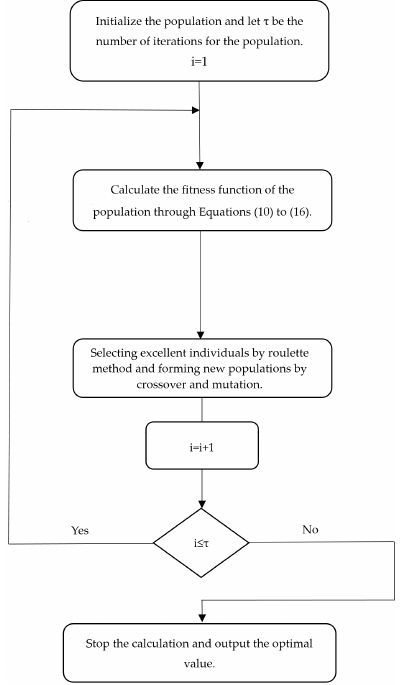
Figure 1. The flowchart of the entire steps for emergency decision making (EDM) with improved genetic algorithm (GA).